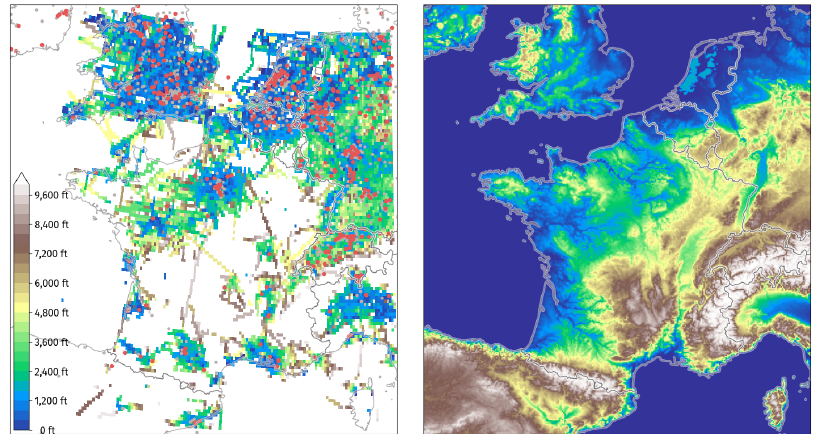
Figure 1. ADS-B coverage (minimal altitude detected) below 10,000ft for aircraft with a non- commercial callsign over Western Europe ( left ) with mountain relief ( right ). Red dots match the location of receivers actively feeding the OpenSky Network on the same